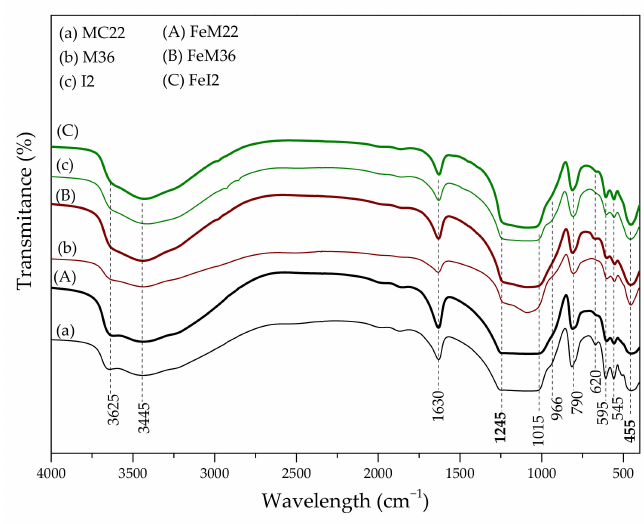
Figure 4. FT-IR spectra of the pristine and Fe-modified MWW